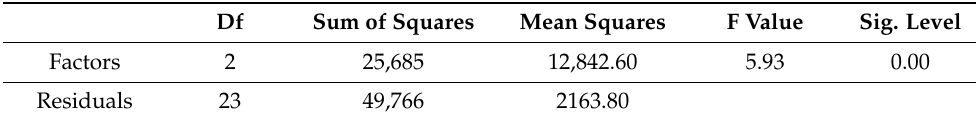
Table 2. Analysis of variance to test the impact of harvesting methods.